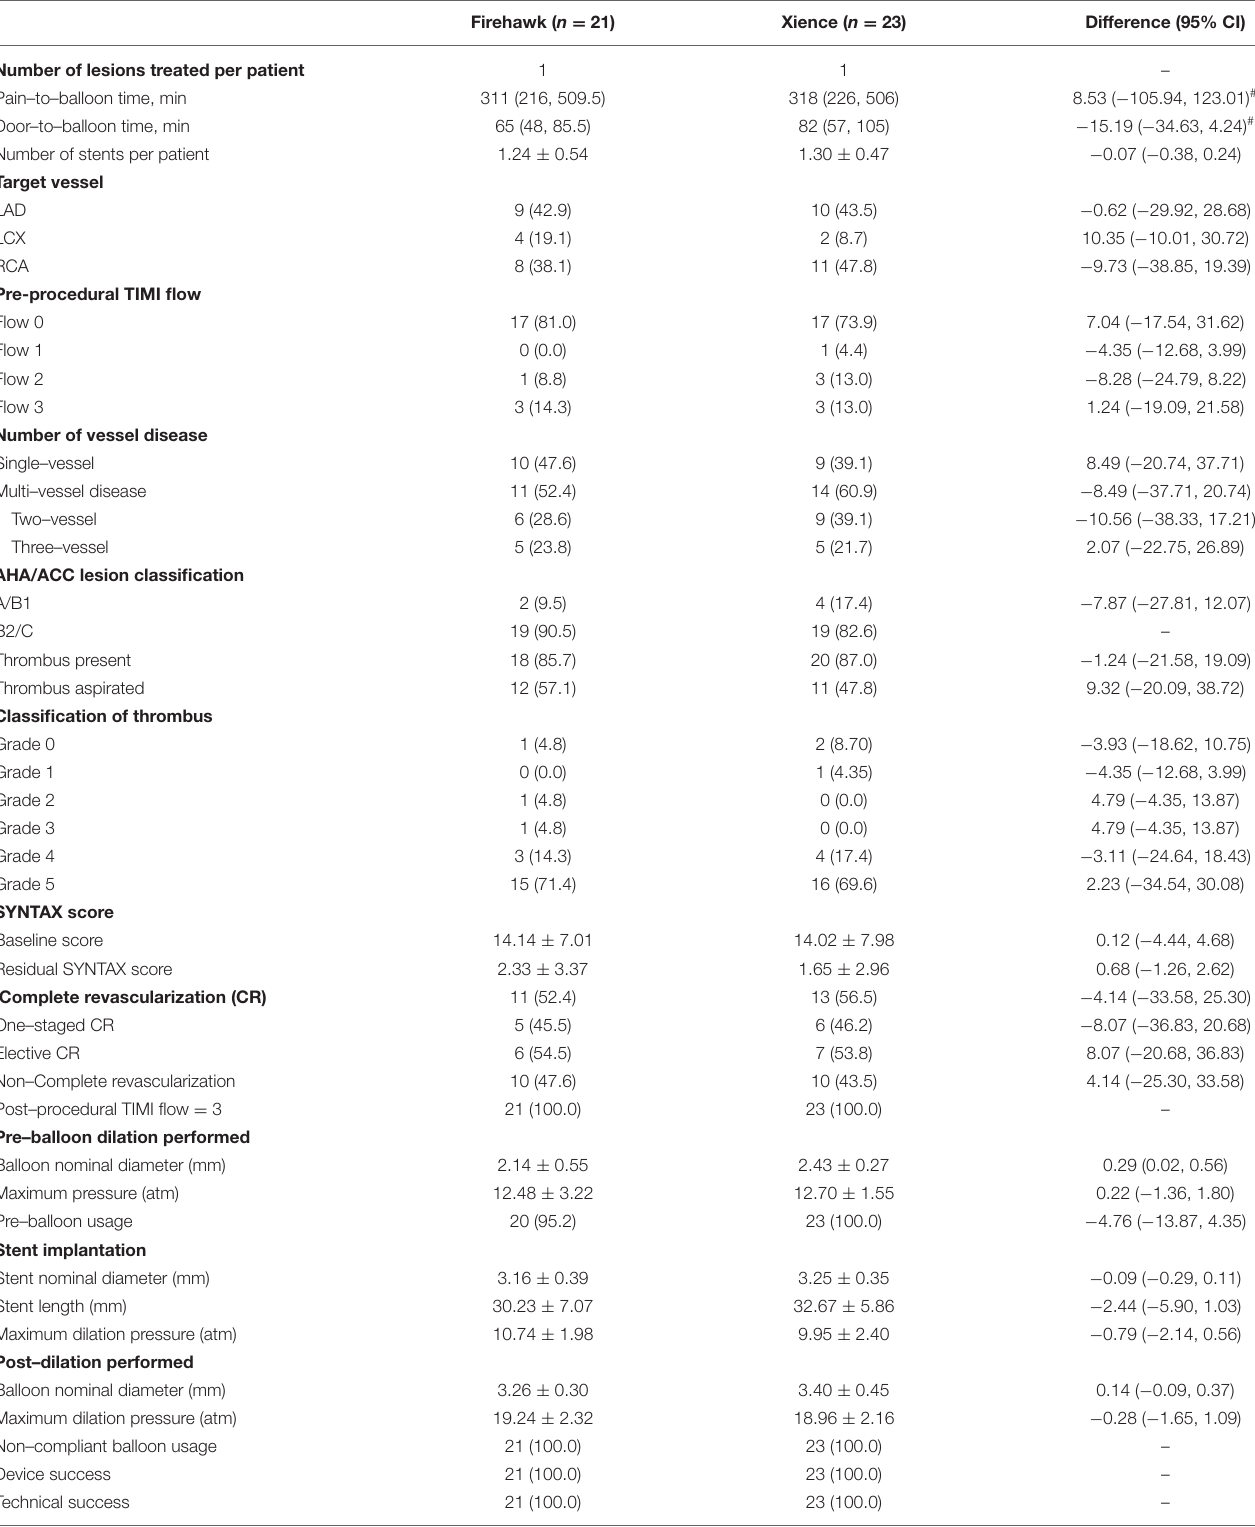
TABLE 2 | Device and procedural characteristics.